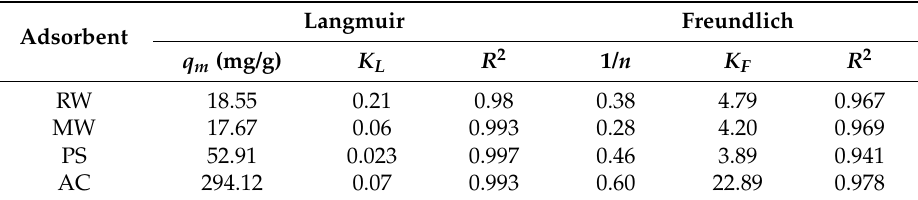
Table 2. Parameters for the Langmuir and Freundlich models.